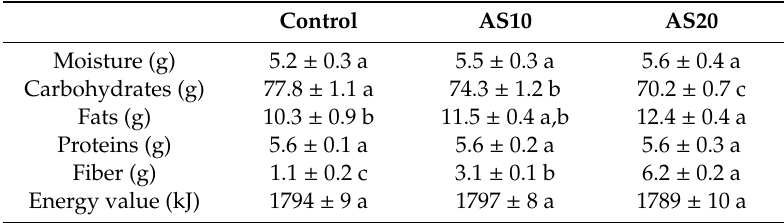
Table 4. Nutritional features (values per 100 g, expressed on fresh weight basis) of biscuits enriched by increasing levels of almond skins. Control = biscuits without almond skins; AS10 and AS20 = biscuits prepared by adding 10 g and 20 g of almond skin powder per 100 g of wheat flour, respectively.